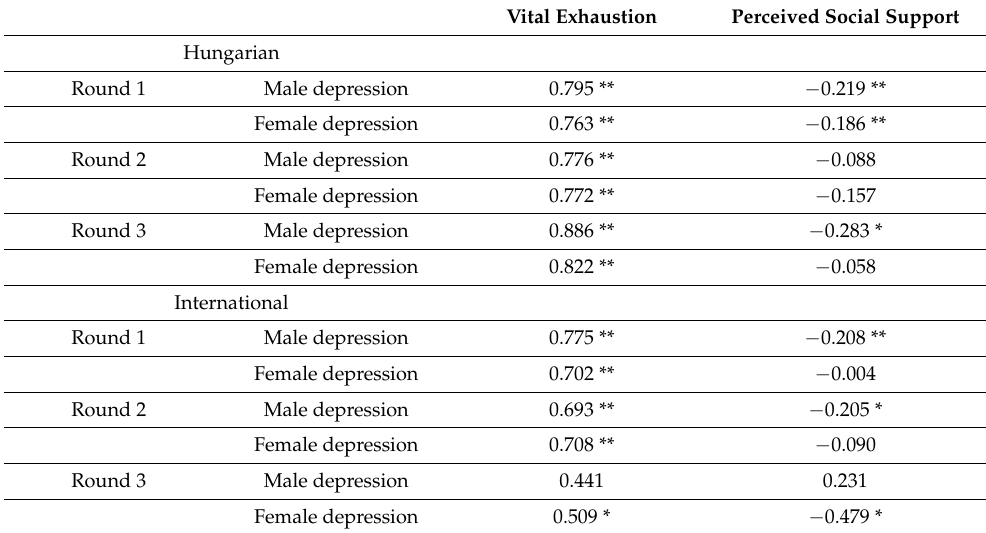
Table 7. Spearman’s rank correlations in the